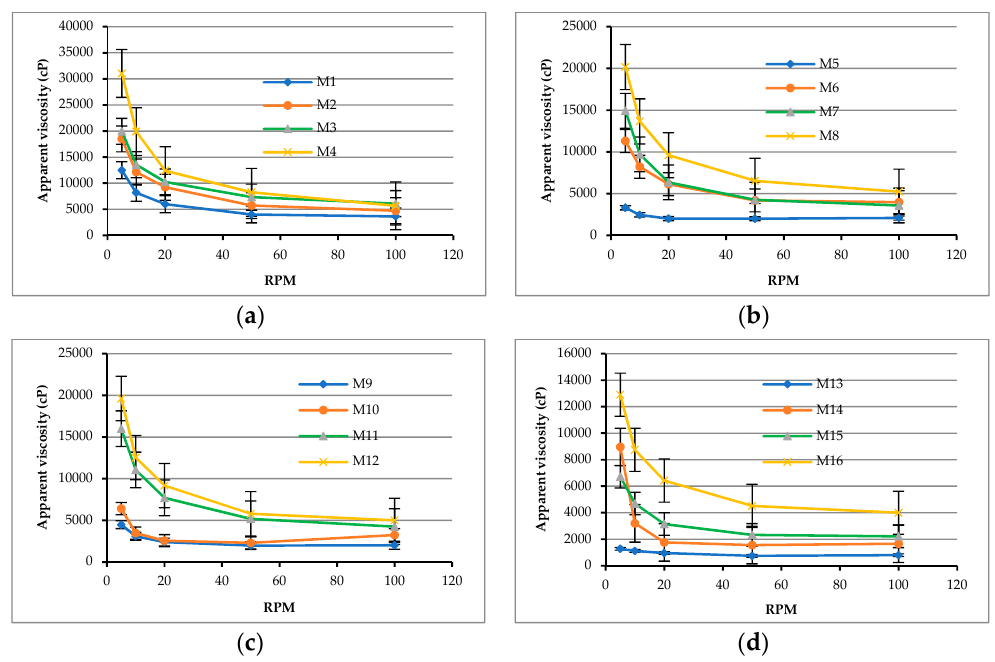
Figure 4. Relationship between the viscosity and the spindle speed of matrixes: ( a ) W/B = 0.28; ( b ) W/B = 0.31; ( c ) W/B = 0.34; ( d ) W/B = 0.37.